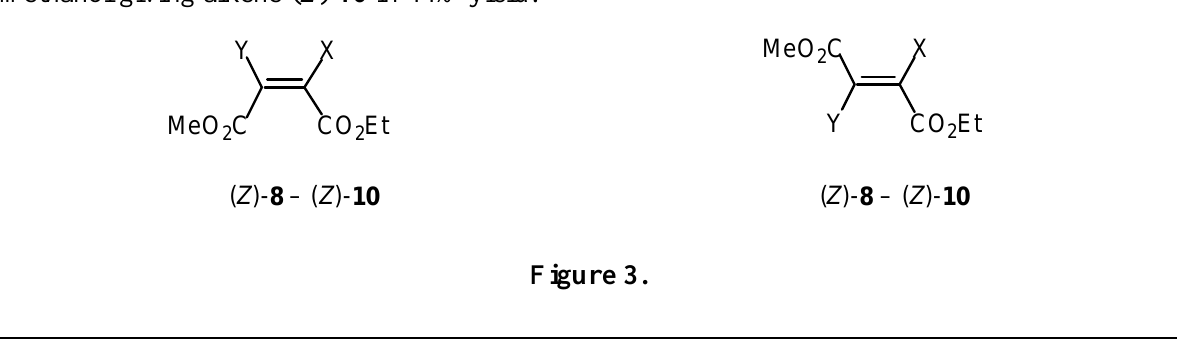
Table 2. Products obtained from the ylide 1g .